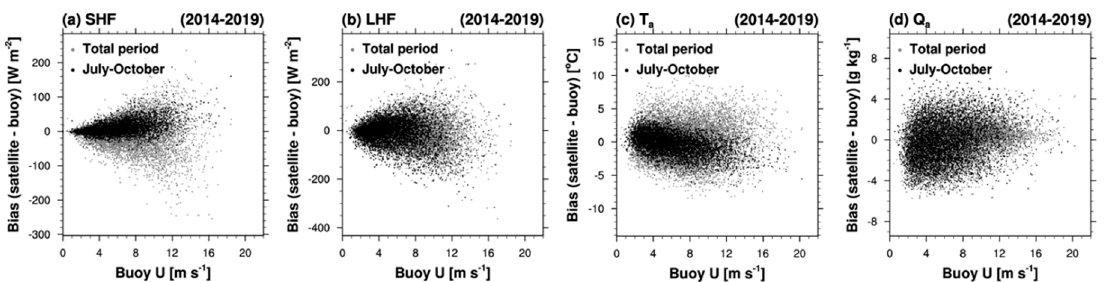
Figure 5. Bias between satellite- and buoy- derived ( a ) SHF, ( b ) LHF, ( c ) T a , and ( d ) Q a for buoy wind speed in the total period (gray dots) and for only June to October (black dots) during 2014–2019.